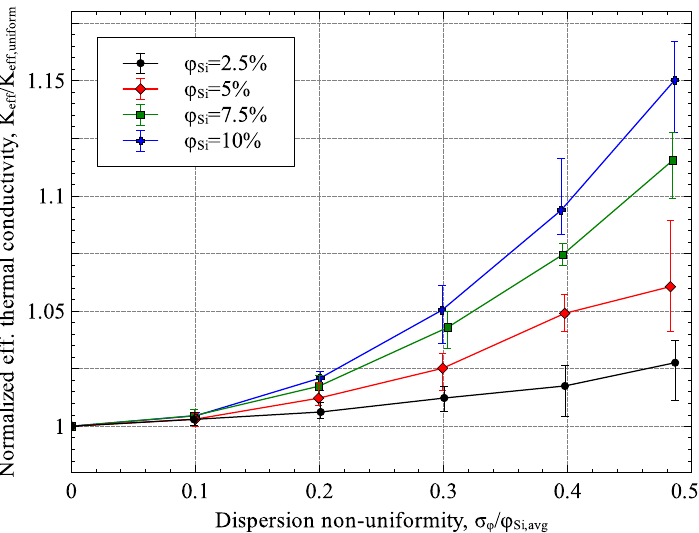
Figure 17. Effect of non-uniform dispersion on Ge–Si effective thermal conductivity ( R TB = 6.80 × 10 − 9 Figure m 2 ·K/W).